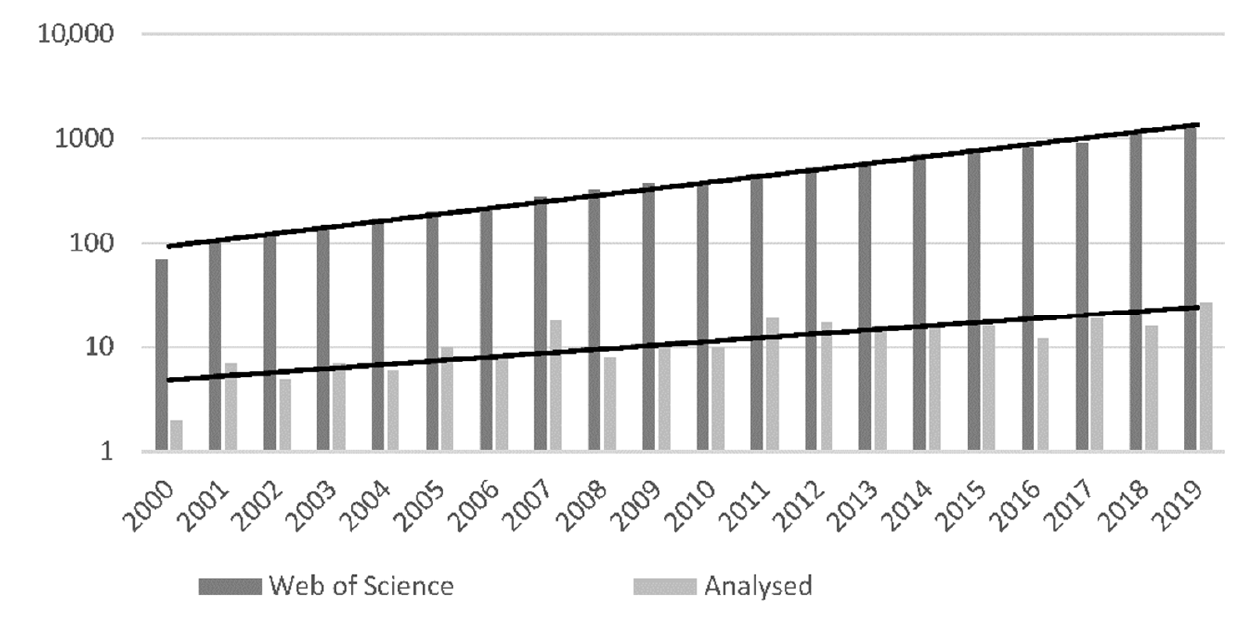
Figure 2. Total number of articles identified by year from Web of Science as potential examples of the STEPLand framework and the 250 manuscripts analyzed.